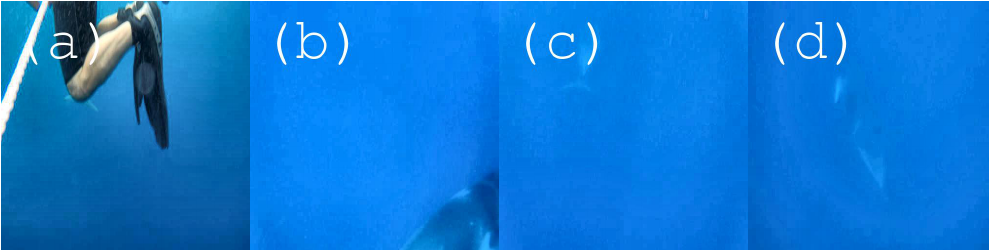
Figure 6. Sub-figures: ( a – d ) are examples of false-negative classification errors by MWD-v2 after the second train-predict project cycle using the first definition of